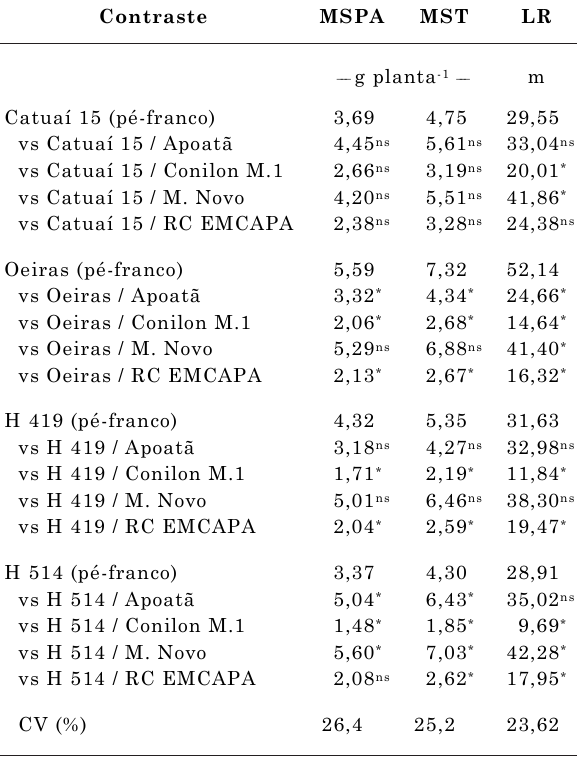
* e ns : contrastes significativos e não-significativos, respectiva- mente, pelo teste “t” de Student a 5